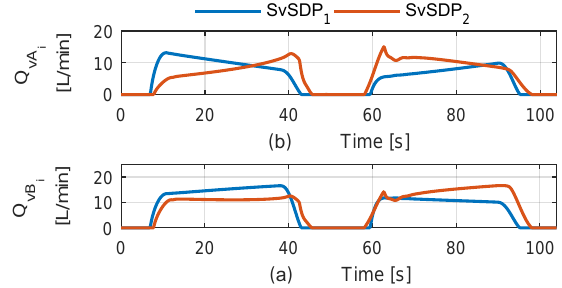
Figure 15: Valve flows for SvSDP drives using original input transformation (Eq (46)). Compare to Fig. 14(f) and (h). degraded energy efficiency for the original input trans- formation is to be